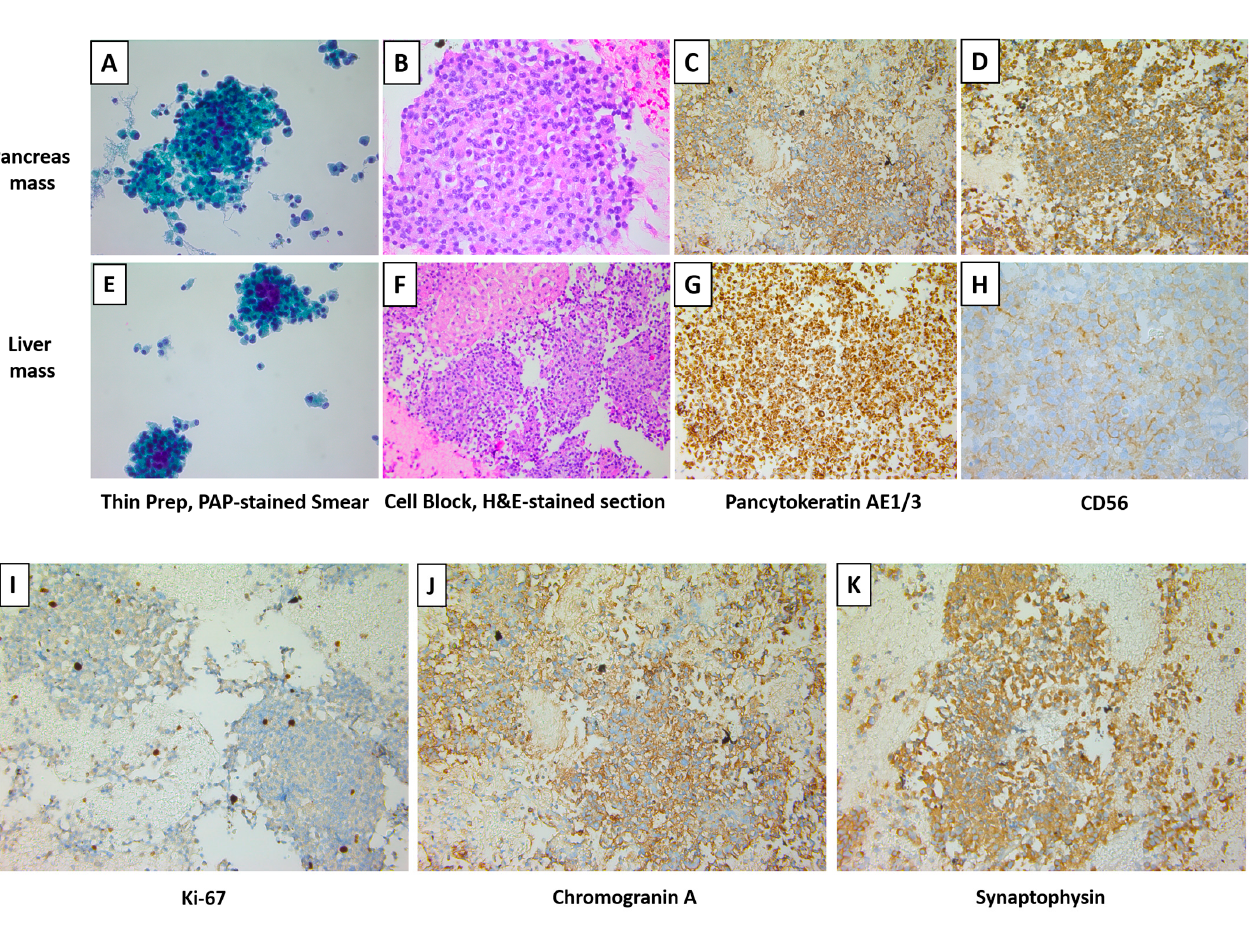
Figure 2. The Cytomorphology, Immunocytochemical, and Biomarker profile of both Liver and Pancreas Lesions. Paraffin embedded cellblock material from fine needle aspiration of the pancreatic and liver masses. ( A , E ): Cellular aspirate of loosely cohesive clusters of cells and single cells (Papanicolaou stain). ( B , F ): Cell block tissue sections (H&E stain). ( C , G ): The cells are positive for pan-cytokeratin stain. ( D , H ): The cells are positive for neuroendocrine marker CD56. ( I – K ): Paraffin embedded cellblock material from fine needle aspiration of the pancreatic mass was subjected to immunohistochemistry staining for Ki-67, chromogranin A, and synaptophysin, all of which are positive. The original magnifications are as follows: × 400 ( A ), × 400 ( B ), × 200 ( C ), × 400 ( D ), × 400 ( E ), × 200 ( F ), × 200 ( G ), × 400 ( H ), × 400 ( I ), × 200 ( J ), and × 200 ( K ). To further characterize this patient’s tumor, genomic sequencing was performed using FoundationOne ® CDx (F1CDx; Supplementary Materials), which is summarized in Table